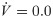
Performance of the motif 1 autocatalytic controller (Eqs 33–35).Phase 1: constant volume V and constant k3. Initial concentrations and rate constant values (at the controller’s steady state): V0 = 25.0, V˙=0.0, A0 = 2.0, E0 = 100.0, M0 = 1 × 106, k2 = 1.0, k3 = 2.0, k3˙=0.0, k4 = 20.0, k5 = 1 × 10−6, k6 = 10.0, kEin=kEout=1×10−5. The controller keeps A at its set-point at Asettheor=k4/k6=2.0. Phase 2: rate constants remain the same as in phase 1, but V increases linearly with V˙=1.0. Phase 3: V continues to increase with the same rate and k3 increases with rate k3˙=1.0. The controller moves A towards Asettheor in both phase 2 and phase 3, but breaks down when no additional E becomes available through M (indicated by the arrow in the right panel).